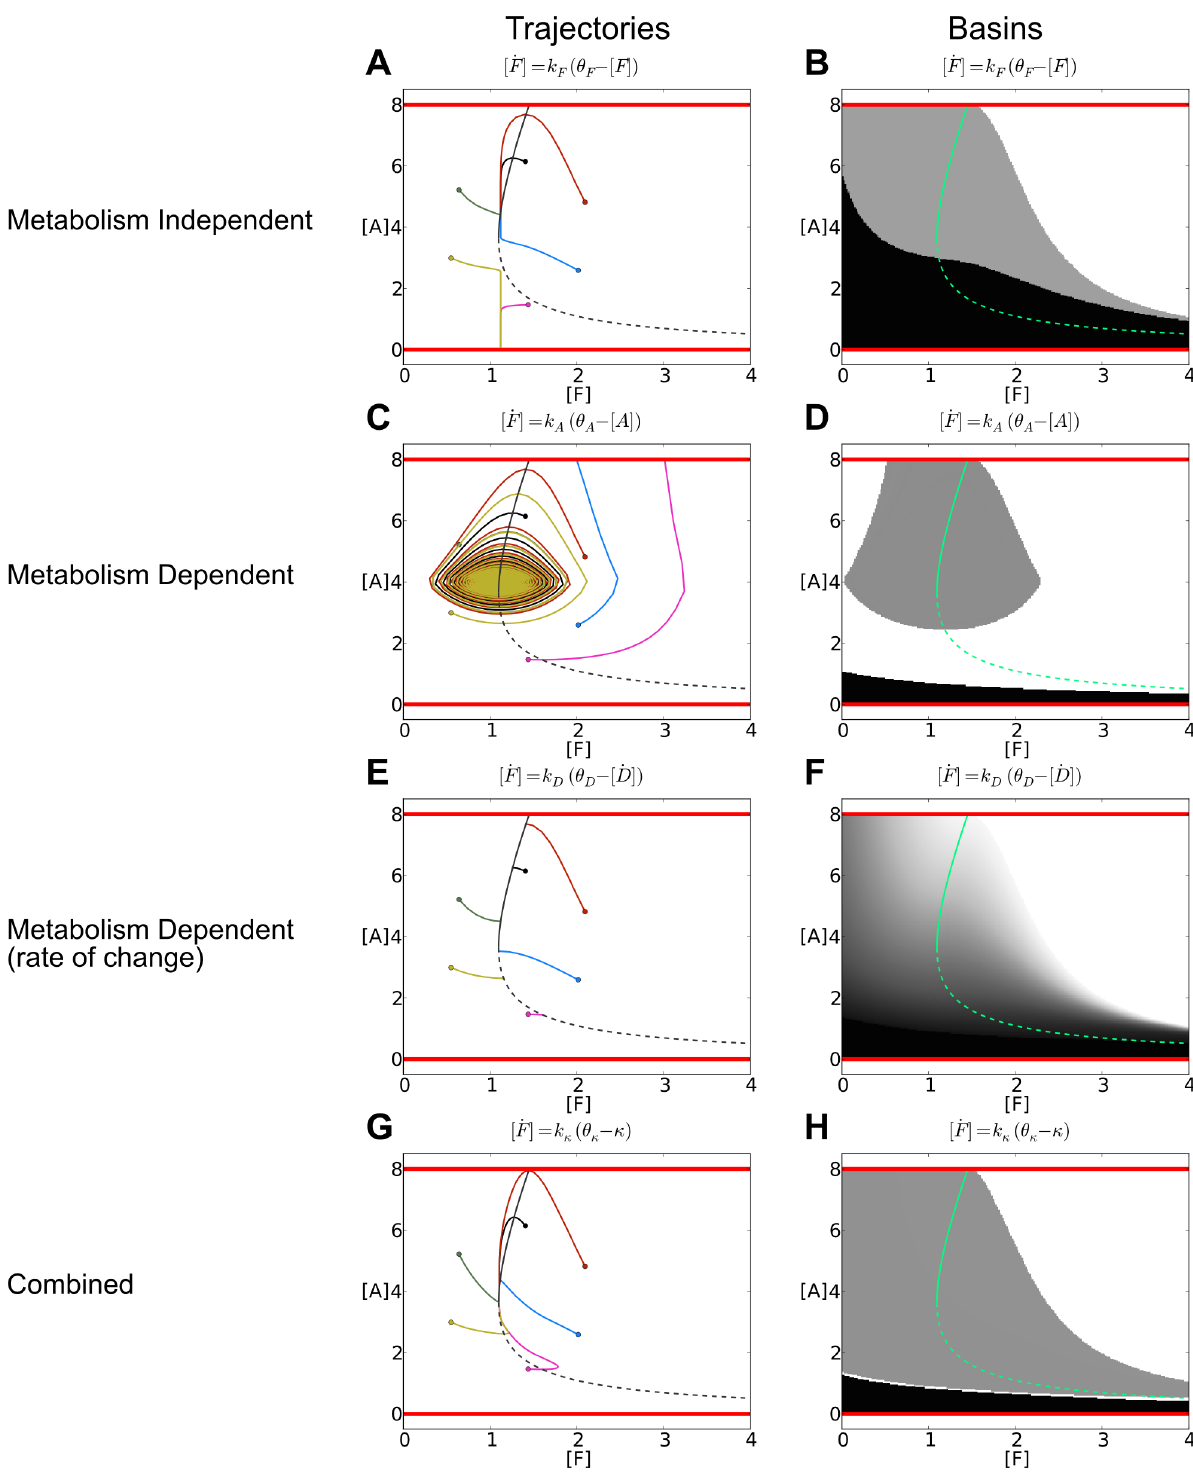
Figure 2. Example trajectories and survivable initial conditions for four different forms of behavior. Each of the left-hand plots indicate six example trajectories through the state space described in Section 2.1. The starting points for these trajectories (indicated by small, filled circles) are the same for each behavior. The right-hand plots indicate the ‘‘survivable initial conditions’’ for the same behaviors. The shade of gray on these graphs indicates ½ A (cid:2) at t ~ 40 for the initial condition indicated by the location of the point on the plot. The white and black regions indicates initial conditions that end in the death states, ½ A (cid:2) ~ 8 and ½ A (cid:2) ~ 0 respectively. The mid-tones indicate initial conditions which survived. For all calculations, the system appeared to have come close to equilibrium before the end of the simulation.